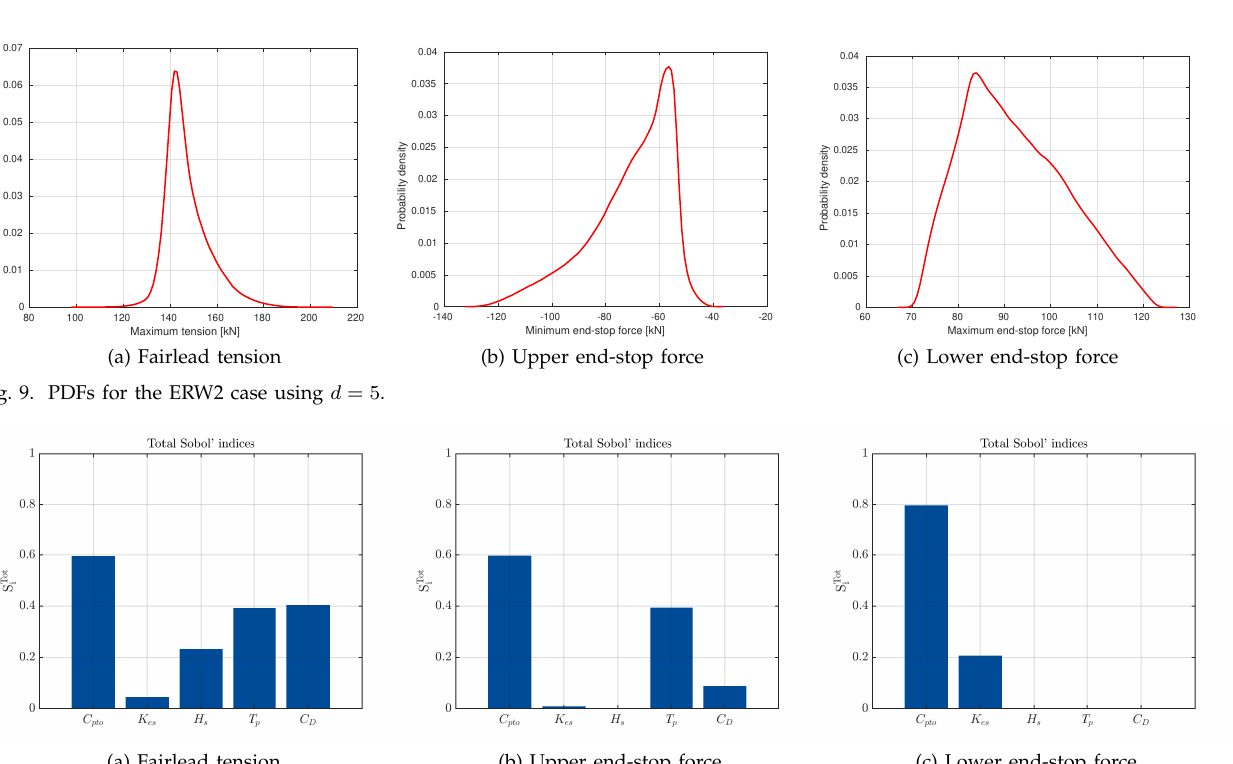
Fig. 10. Total sensitivity index for the ERW2 case using d = 5